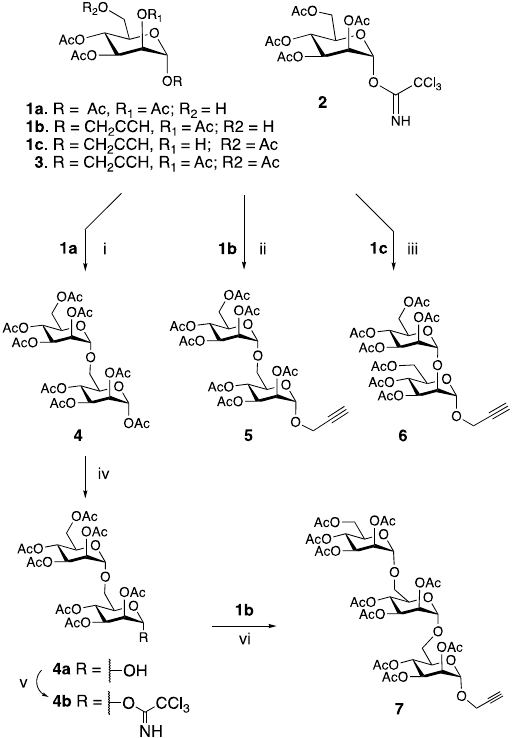
Scheme 2. Synthesis of sugar ‐ modified malondiamide linkers. Experimental conditions: (i) 3 ‐ chloro propylamine, NaN 3 , H 2 O, 80 °C, 6 h (91%); (ii) malonyl chloride, aqueous NaOH, CH 3 Cl, 0 °C, 20 min (44%); (iii) CuSO 4 , Na ascorbate, THF/ H 2 O,